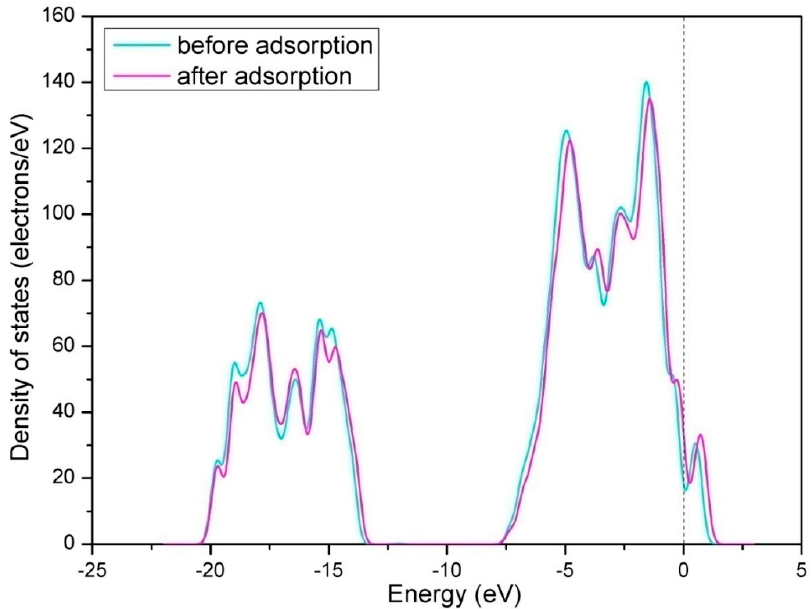
Figure 4. Total density of states of the perfect LaO-terminated LaCoO 3 (011) surface before and after NO adsorption. Zero energy is the Fermi level, which is denoted as the vertical dotted line.